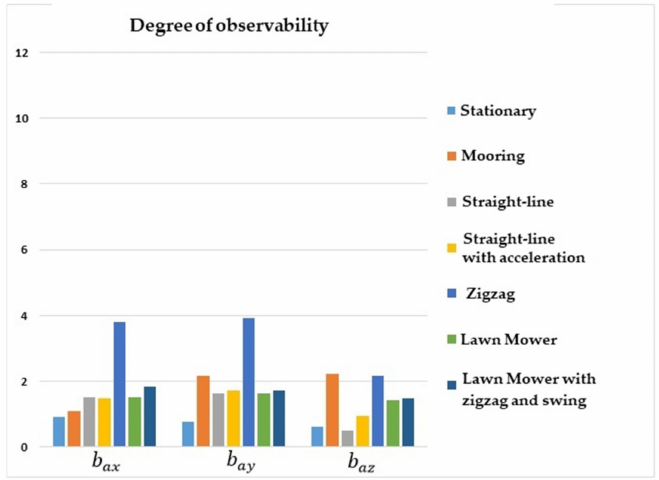
Figure 11. Degrees of observability of the accelerometer biases. INS/DVL integration.